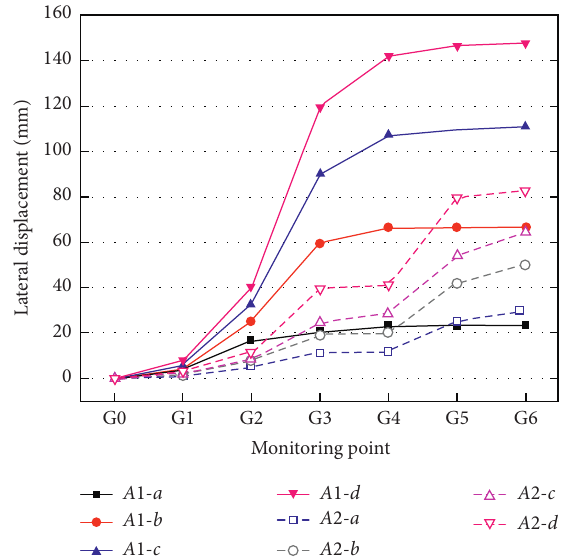
Figure 13: Lateral deformation of the piles in areas A